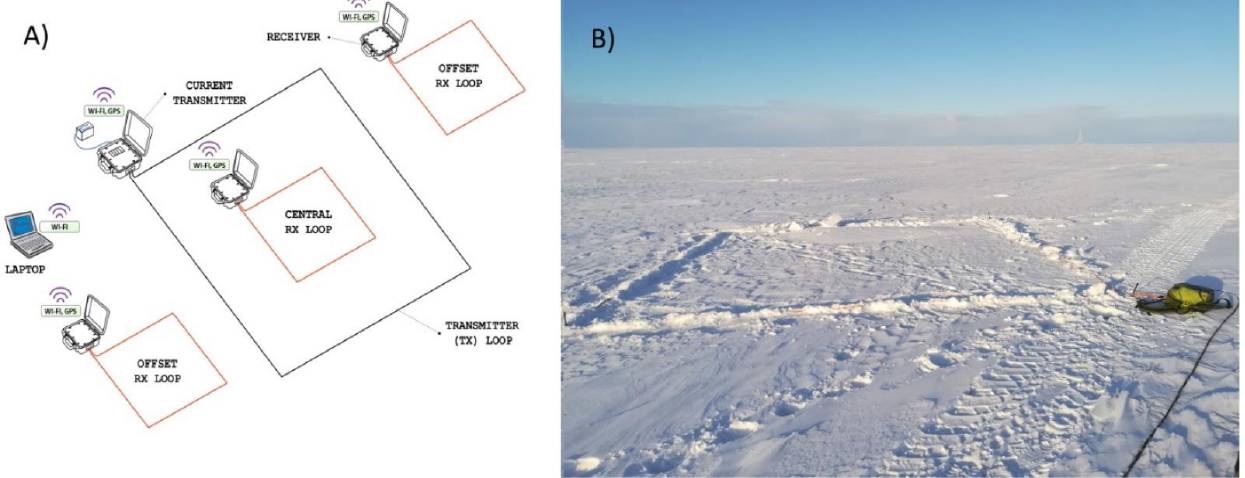
Figure 1. sTEM layout: FastSnap configuration ( A ) and field example from the Yamal Peninsula ( B ). The picture in panel ( B ) shows a laid receiver loop and a FastSnap box.